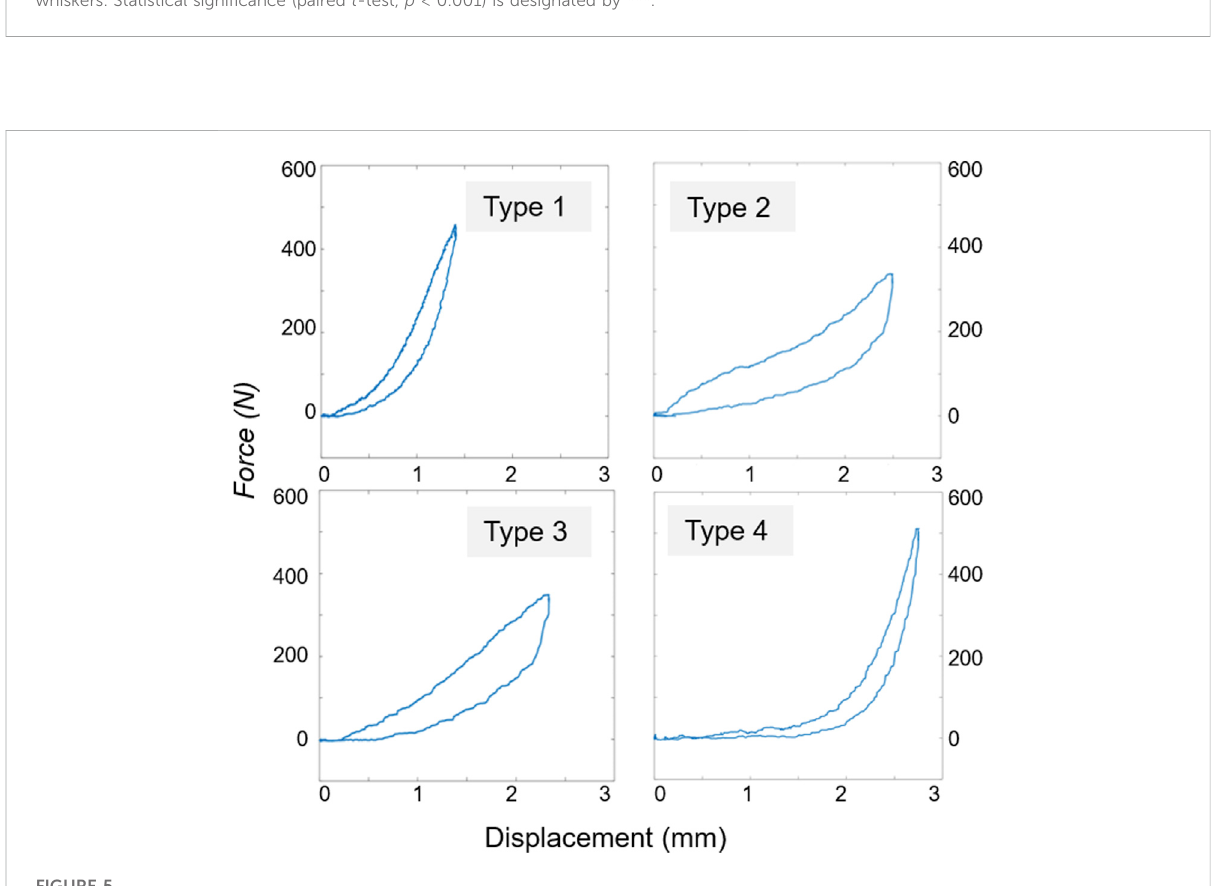
FIGURE 5 Typical load-displacement curves found for the 27 specimens depending on the testing conditions (disc condition, motion) resulting in 104 tests. Type 1: the majority of the tests (79/104) was described with an exponential toe region, and linear elastic part which were fi tted following Tanakaetal.,2011model.Type2:S-shapedwasfollowedby2/27specimensinnucleotomy fl exionand7/27incementdiscoplasty fl exion.Type3:1/ 27 specimens in nucleotomy extension, 1/27 in cement discoplasty extension, and 4/27 in discoplasty fl exion followed a fl at toe region and linear elastic region. Type 4: L-shaped was followed by 10/27 specimens in nucleotomy